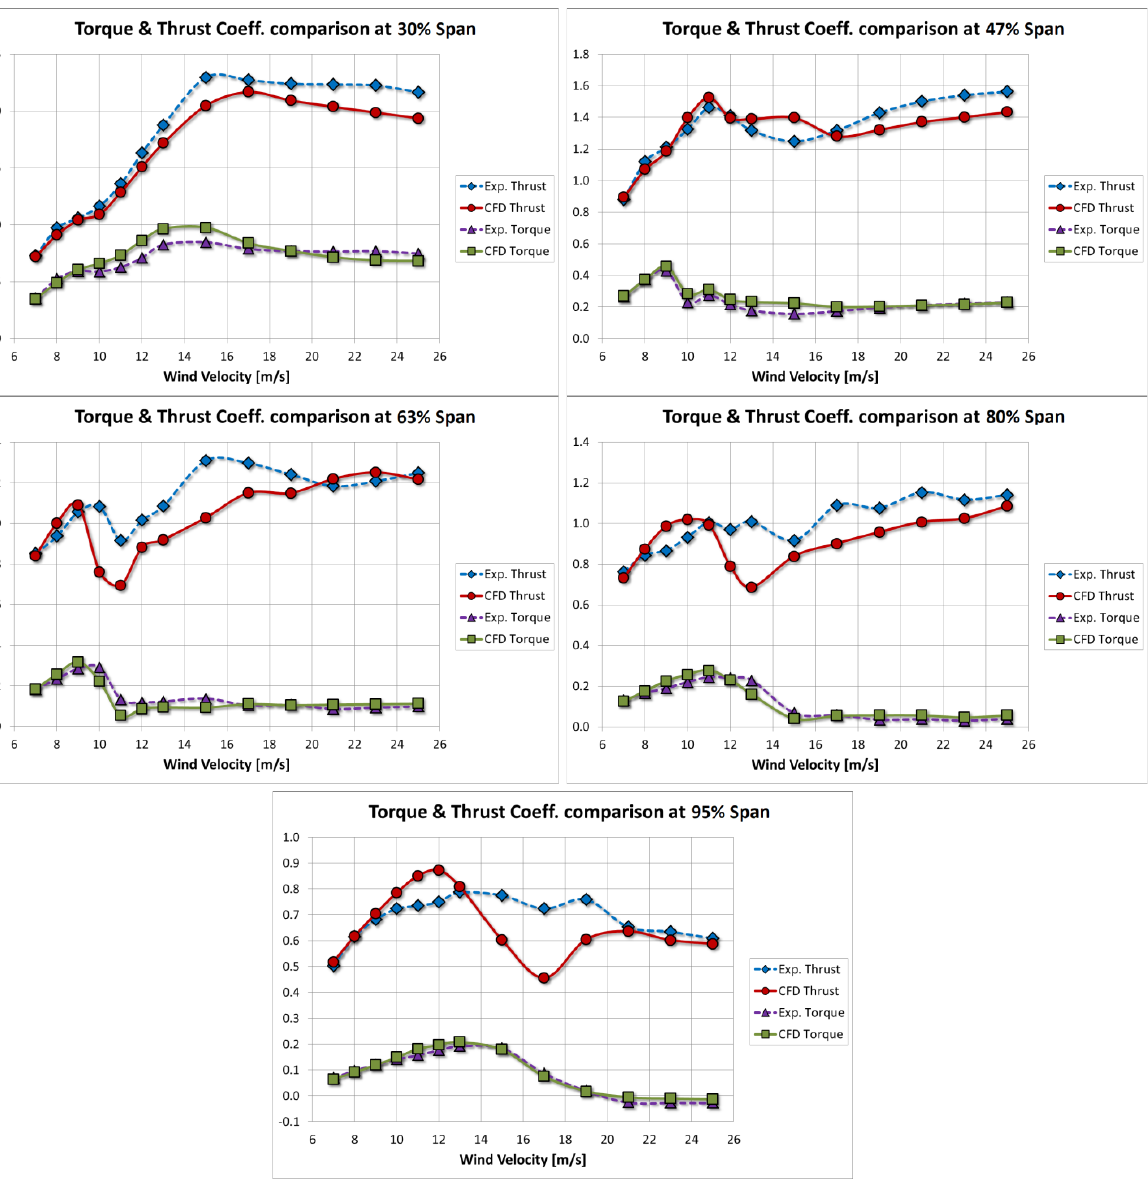
Figure 13. Torque & thrust coefficients vs. data derived from measurements at all wind velocities. Values are compared at the five spanwise blade stations used for pressure measurements: 30%, 47%, 63%, 80% and 95%. Experimental data is represented using dotted curves and numerical data is drawn as solid curves.